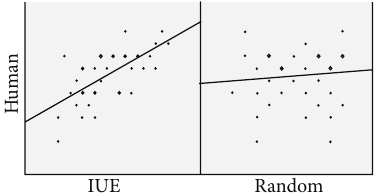
Figure 3: Visualizing the correlation between the IUE tool, random baseline, and human annotators for the task of detecting heading- to-content semantic relatedness.